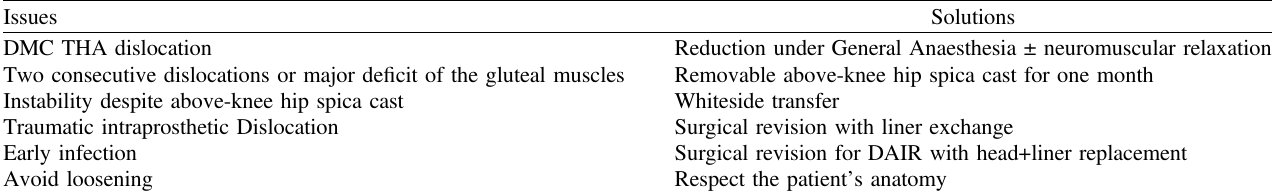
Table 5. Tips and tricks for DMC complications